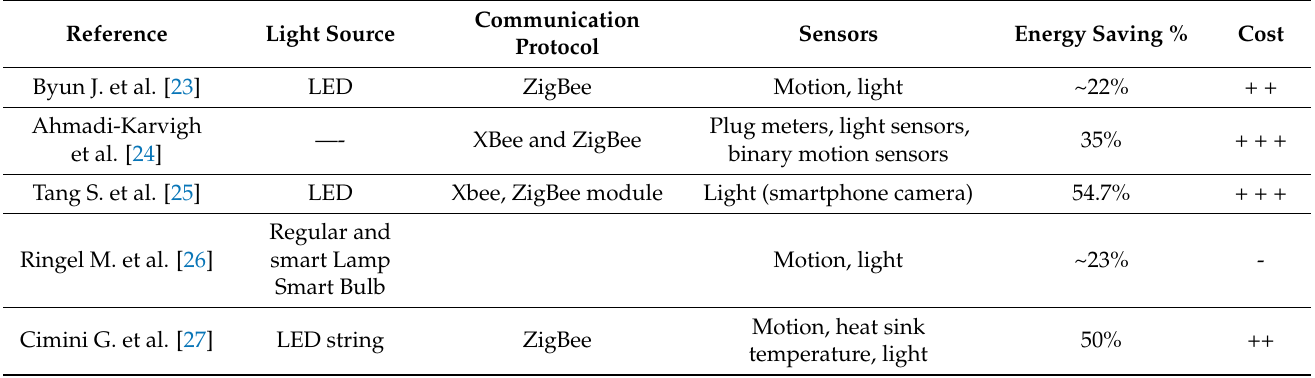
Table 5. Comparative study of smart lighting technologies, energy saving and cost